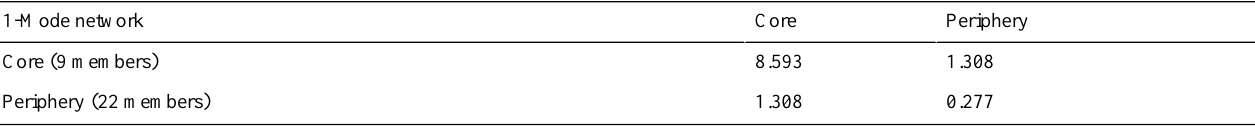
Table 4. Communication densities stratified by the core-periphery structure in the 1-mode network.